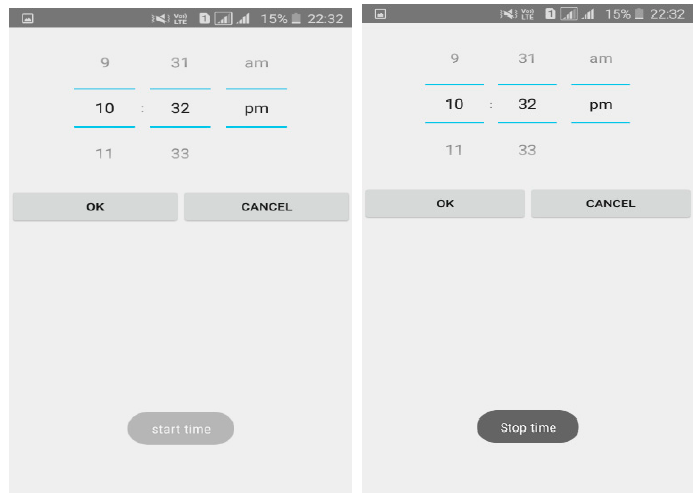
Figure 5. Start time and end time. ( a ) Start time ( b ) Stop time.